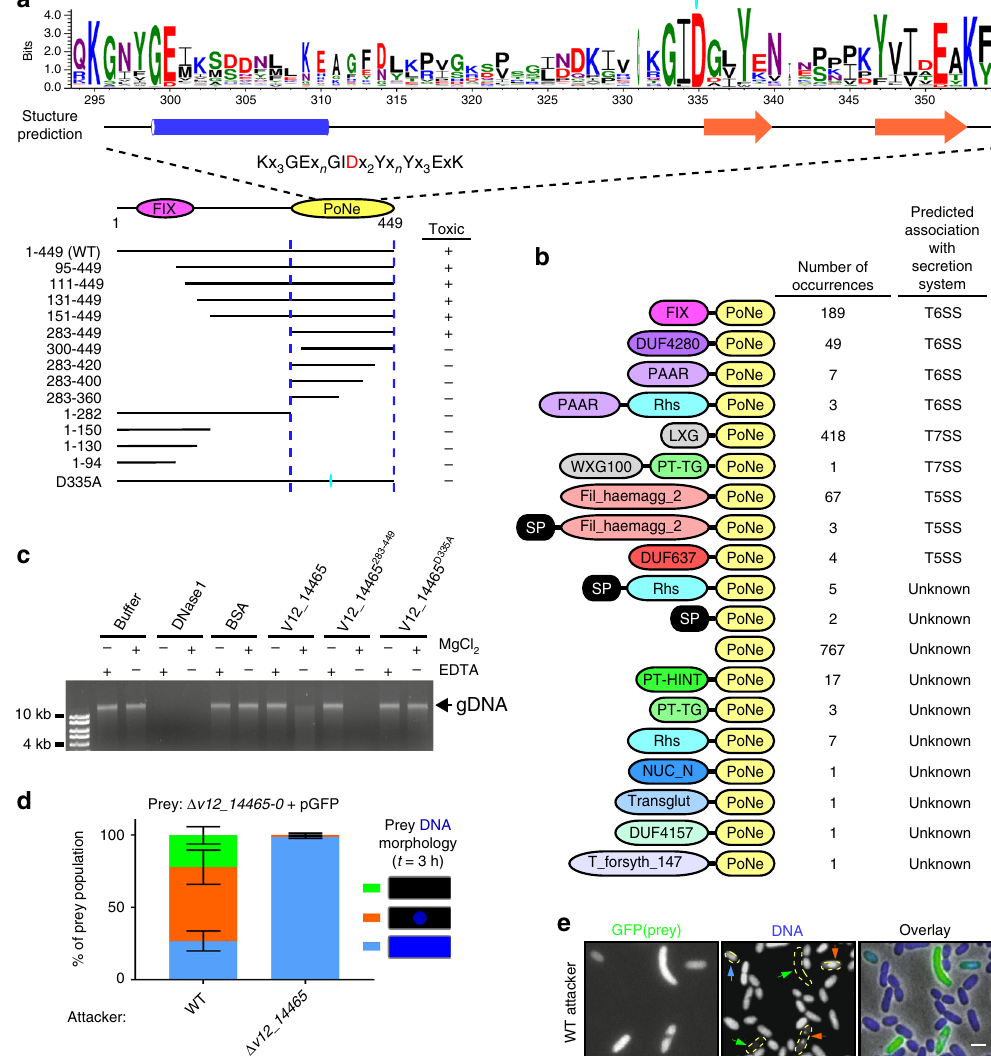
Fig. 2 Effector V12_14465 contains a new DNase domain. a Schematic representation of full-length and truncated V12_14465 forms tested for toxicity upon expression in E. coli . The region necessary and suf fi cient for toxicity is denoted by dashed vertical blue lines (based on the results shown in Supplementary Fig. 5). The region of the toxic C-terminal domain (PoNe) in which a conserved motif was identi fi ed (residues 294 – 354) is illustrated using WebLogo 3. Secondary-structure prediction (Jpred) and the conserved motif are provided. Alpha helix is denoted as blue cylinder, and beta strands as orange arrows. A cyan oval above the WebLogo denotes the catalytic aspartic acid at position 335. b Domain architectures of PoNe-containing proteins. SP, signal peptide. c In vitro DNase activity assay. Puri fi ed E. coli genomic DNA (gDNA) was co-incubated with buffer or with the indicated puri fi ed proteins in the presence ( + ) or absence ( − ) of Mg 2 + or EDTA at 37 °C for 30 min. The integrity of gDNA was visualized on 1% agarose gel. d Quanti fi cation of V. parahaemolyticus 12-297/B Δ v12_14465-0 prey cells, constitutively expressing GFP from a plasmid (pGFP), that present DNA morphologies: DNA across entire cell area (cyan), DNA nucleoid or foci (orange), or no DNA (green). DNA was detected using Hoechst dye fl uorescence signal after 3 h of co-incubating prey with the indicated attacker strains. Results shown are average ± S.D. of three independent biological replicates. In each experiment, 100 prey cells were evaluated per treatment. e Sample images of prey cells described in d after 3 h of co-incubation with WT attackers. Dashed yellow shapes in DNA channel encircle prey cells detected in the GFP channel. Colored arrows denote prey cells presenting each of the three DNA morphologies described in d . Bar = 2 µ m. WT wild-type. Source data are provided as a source data fi